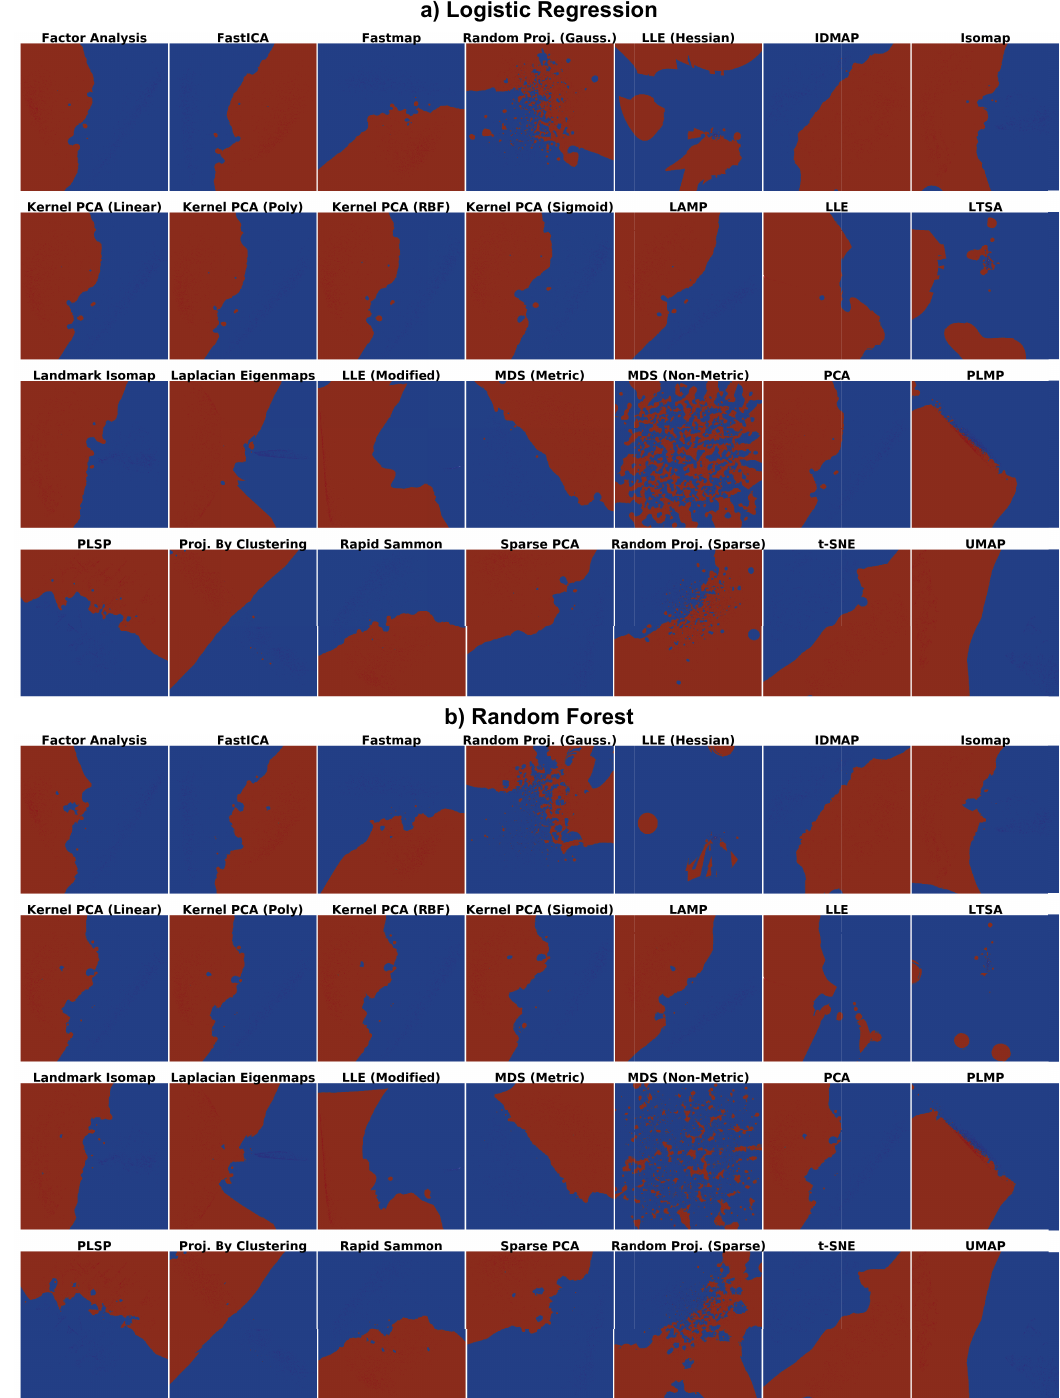
Figure 2. Dense maps for Logistic Regression ( a ) and Random Forest ( b ) classifiers on the 2-class S 2 dataset, all 28 tested